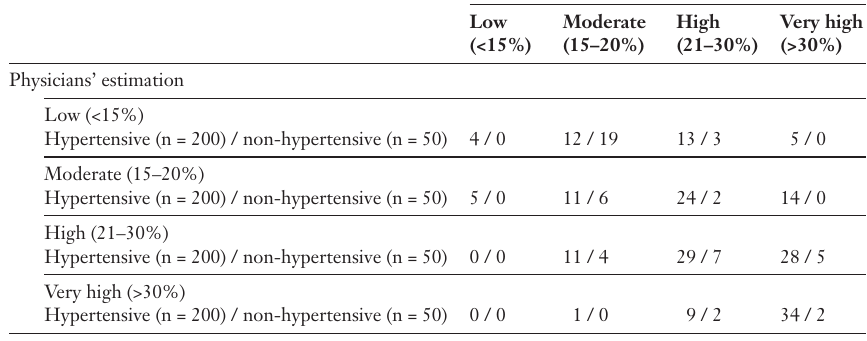
Figure 1 Distribution of the physician-perceived and computer-calcu- lated cardiovascular risk in 200 hyper- tensive and 50 non- hypertensive patients.